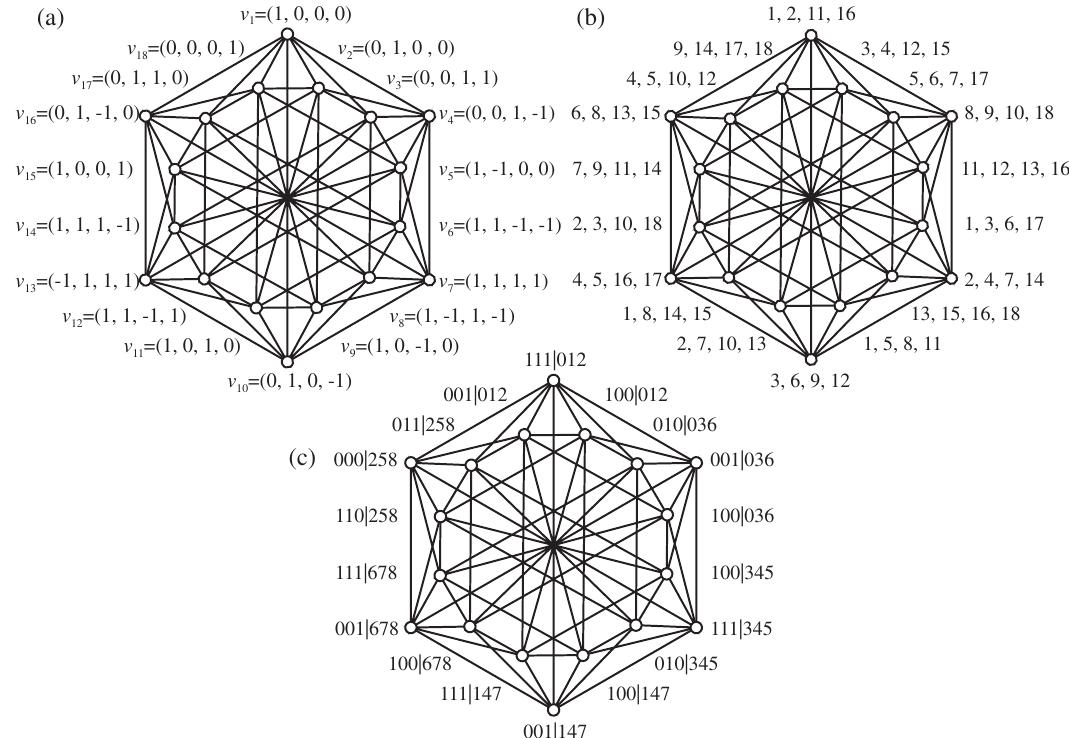
FIG. 1. (a) The 18-test KS set. Each vertex represents a yes-no test (associated in QM with a projector (cid:1) i ¼ j v i ih v i j , where h v i j are the unit vectors displayed in the Figure; normalization factors are omitted to simplify the notation), and adjacent vertices correspond to exclusive tests (i.e., they cannot both have the answer yes on the same system; in QM, they are associated with orthogonal projectors). This vector representation is the one that is adopted in our experiments. (b) Optimal strategy for the task that is described in the text using classical resources. The system is a ball that can be placed in one out of 18 boxes, and ‘‘1, 2, 11, 16’’ denotes the following yes- no test: ‘‘Is the ball in box 1 or in box 2 or in box 11 or in box 16?.’’ The set of classical tests in (b) results in the maximum probability of obtaining yes by using classical resources (see the Supplemental Material [39]). (c) Propositions tested in the noncontextuality inequality (5) that are used to obtain state-independent maximally contextual quantum correlations. Each vertex represents a proposition abc j xyz that denotes that ‘‘the result of measuring x is a , the result of measuring y is b , and the result of measuring z is c .’’ When the measurements are those measurements in (4), then each of these sequences of measurements and results projects any initial state onto the corresponding state in